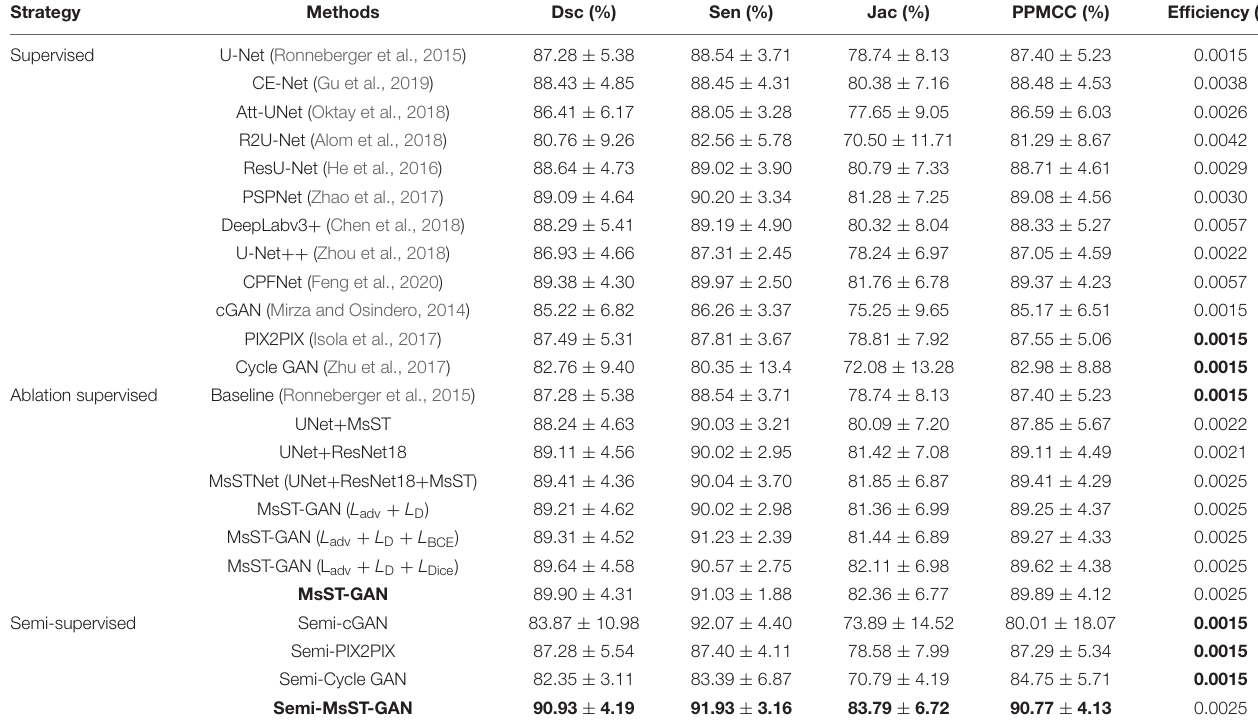
TABLE 2 | Evaluation indices for different methods.